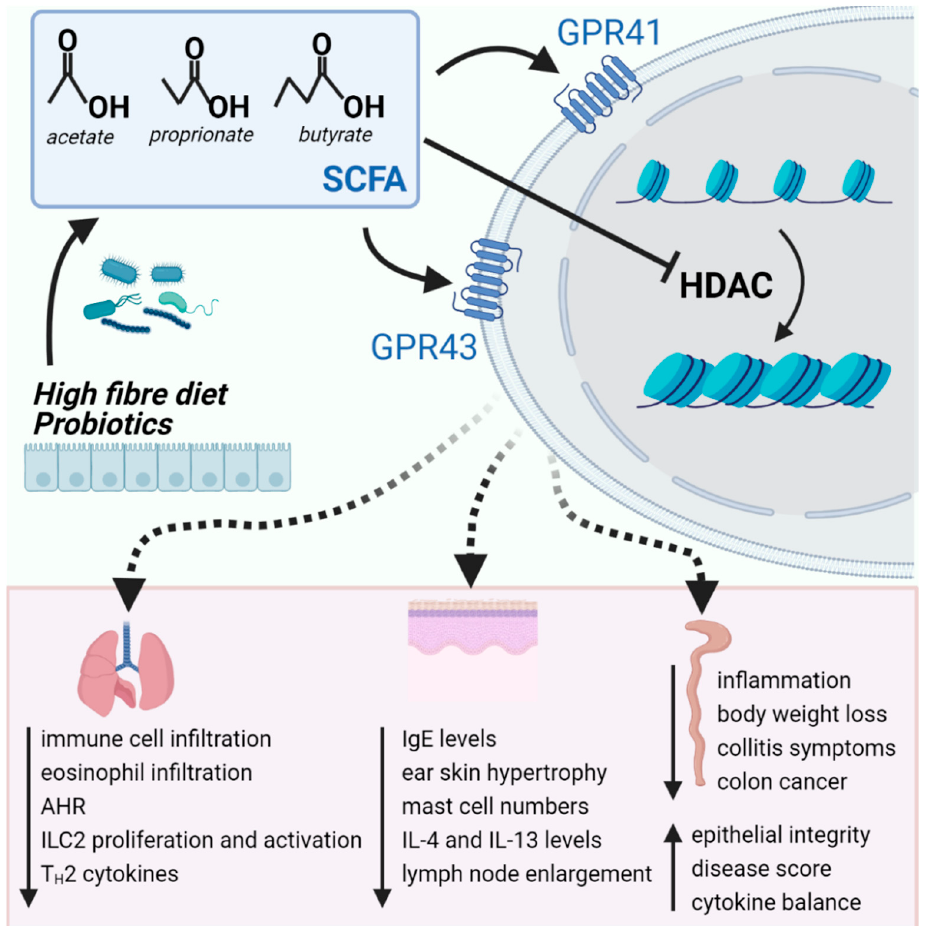
Figure 2. Short chain fatty acids produced by the gut microbiota bind to its receptors and/or act as histone deacetylase inhibitors reducing inflammation in the lungs, skin and gut. Abbreviations: AHR, airway hyperresponsiveness; HDAC, histone deacetylase; IgE, immunoglobulin E; ILC2, type 2 innate lymphoid cells; SCFA, short chain fatty acids.